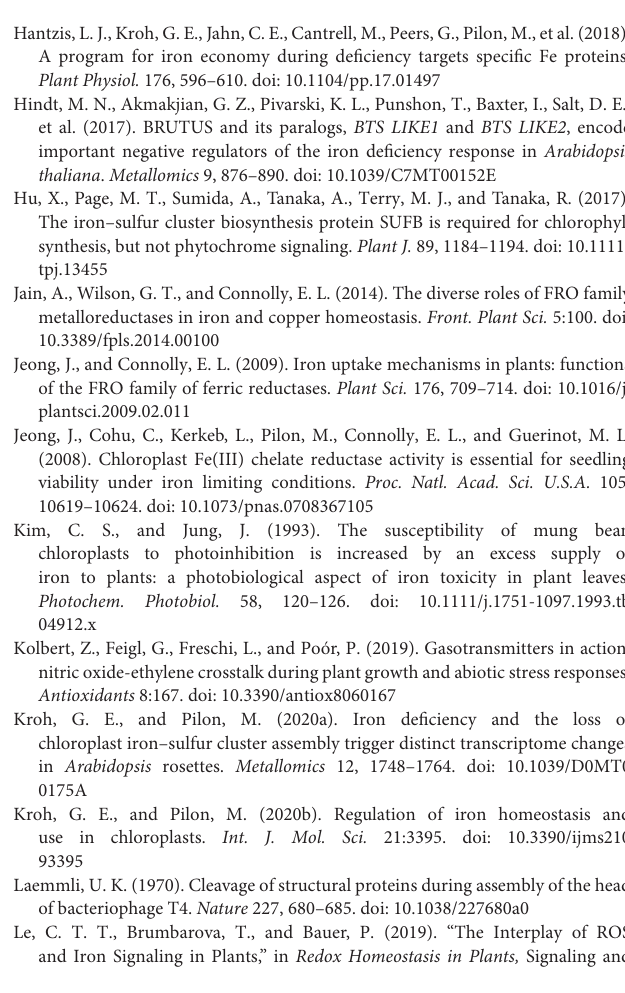
Supplementary Figure 1 | Transient expression of BnFRO7-GFP construct in first leaves of common bean. Supplementary Figure 2 | Presence of chloroplast transit peptide in BnFRO7. Supplementary Figure 3 | Relative transcript amount of BnABCI8 in 4th leaves. Supplementary Figure 4 | Relative transcript amount of BnABCI8 in 6th leaves. Supplementary Figure 5 | Purity of chloroplast inner envelope